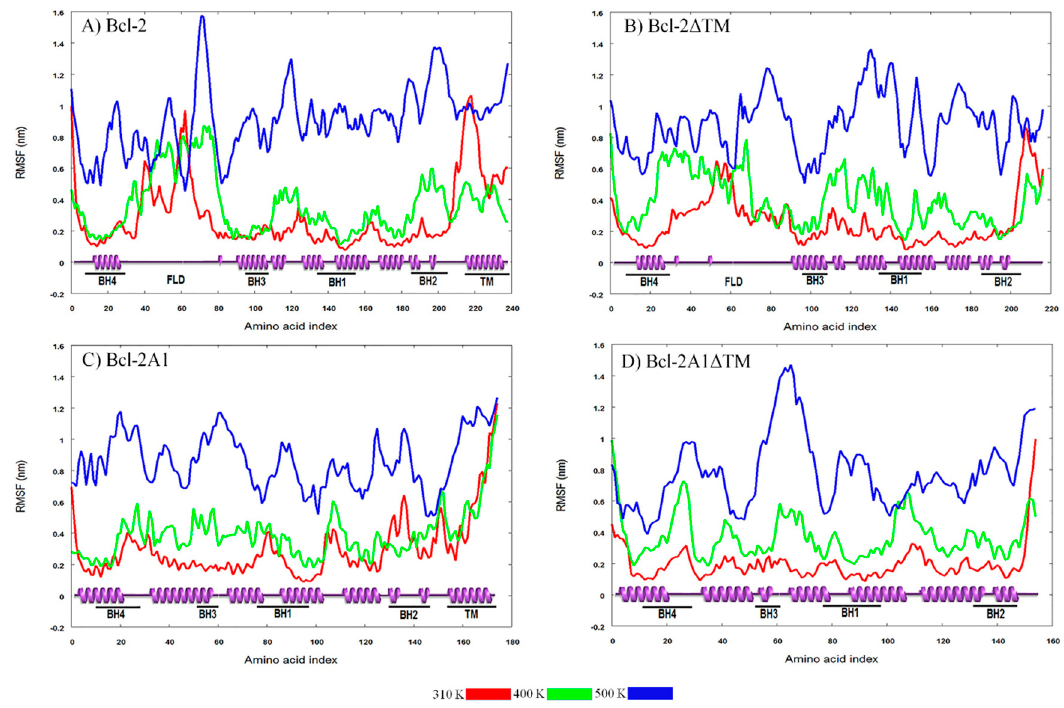
Figure 5. Root mean square fluctuations (RMSF) of the C- α atoms of ( A ) Bcl-2; ( B ) Bcl-2 ∆ TM; ( C ) Bcl-2A1, and ( D ) Bcl-2A1 ∆ TM, as a function of residue number. At the bottom of each plot, a representation of the secondary structure with labels for the main domains is included. Colors indicate the temperature of the MD simulation.